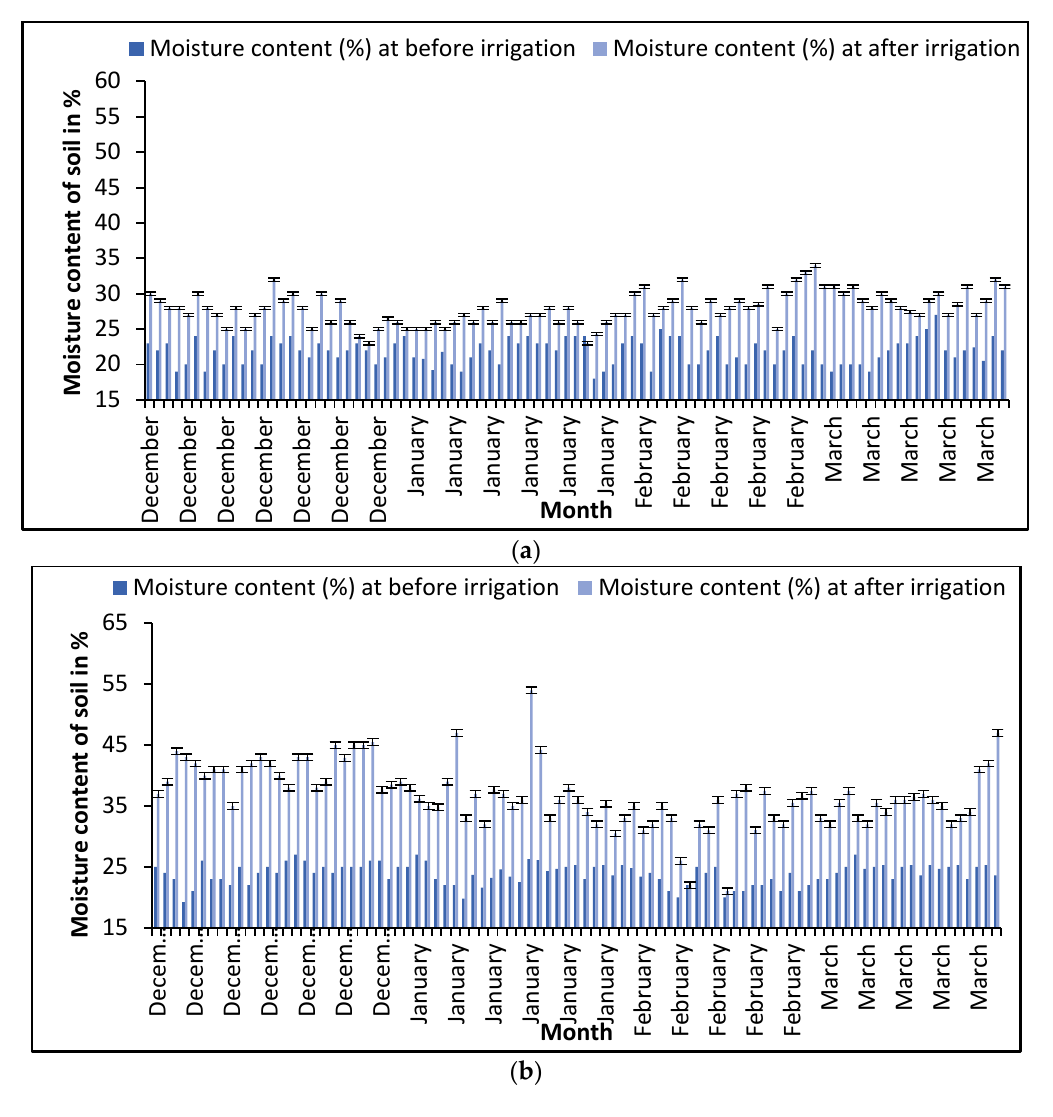
Figure 7. Moisture content (%) at 15 cm depth before and after irrigation: ( a ) Drip irrigation ( b ) Traditional